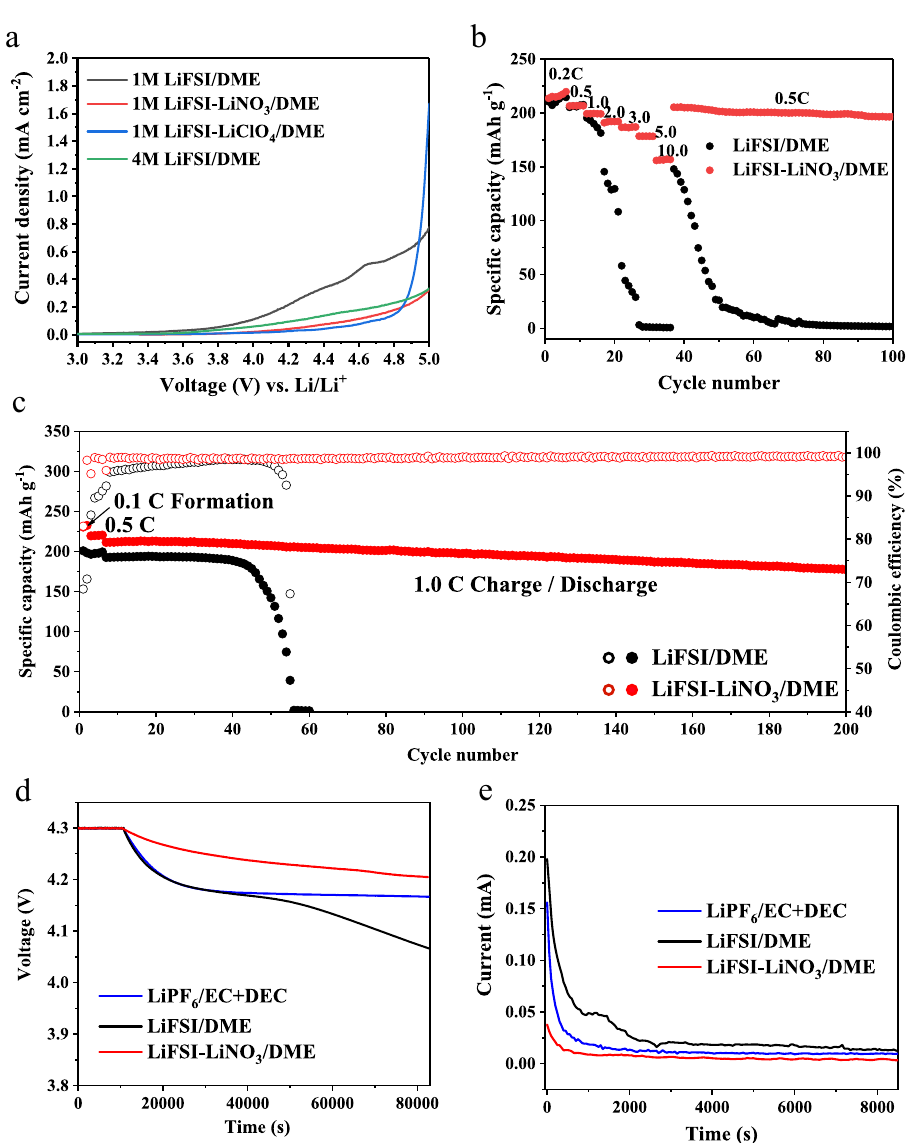
Fig. 2 Comparison of electrochemical properties of LiFSI/DME and LiFSI – LiNO 3 /DME. a Oxidative stability measured via LSV for Li | |Al cells. b Rate capability of Li | |NMC811 cells under different charging/discharging rates. c Long-term cycle performance of Li | |NMC811 cells using different electrolytes at 1.0 C rate. d Self-discharge tests after a potentiostatic hold at 4.3 V vs Li/Li + . e Typical current relaxation curves collected from Li | |NMC811 half-cells during a potentiostatic hold at 4.3 V vs Li/Li +